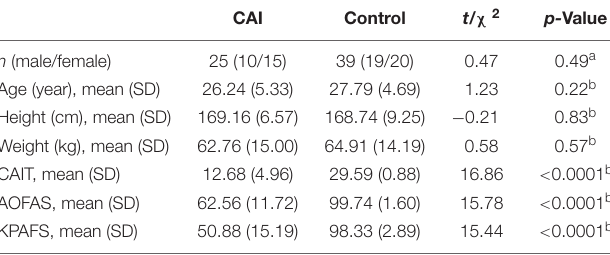
a Chi-square test. b Independent t-test. SD, standard deviation; CAI, chronic ankle instability; CAIT, Cumberland Ankle Instability Tool; AOFAS, American Orthopedic Foot and Ankle Society Score; KPAFS, Karlsson–Peterson Ankle Function